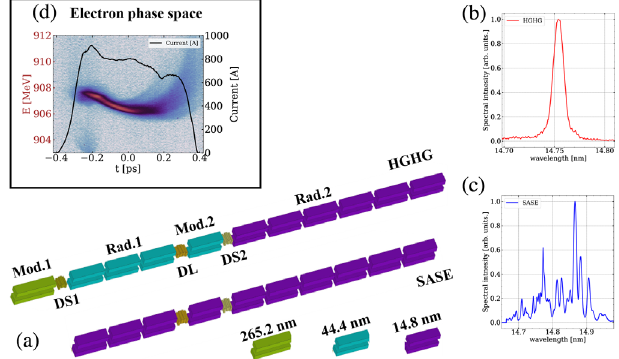
FIG. 1. (a) FERMI FEL operated in HGHG (top) and SASE (bottom) configurations. The layout consists of a first-stage modulator (Mod.1) and a first dispersive section (DS1), only used in HGHG mode, a first-stage radiator made of three undulator sections (Rad.1) a delay line (DL), a second-stage modulator (Mod.2), a second dispersive section (DS2) and finally a second-stage radiator made of six undulator sections (Rad.2). The different undulators are color-coded, based on their resonant wavelength. (b) Typical HGHG and (c) SASE spectra at about 14.8 nm. (d) Electron-beam phase space measured at the end of the linear